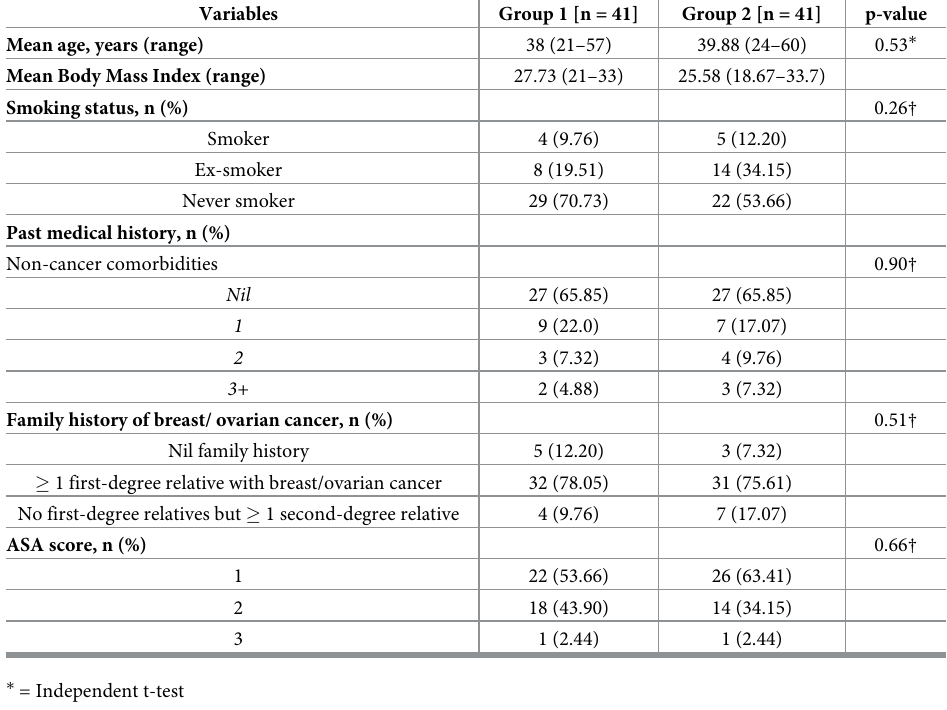
Table 1. Summary of patient